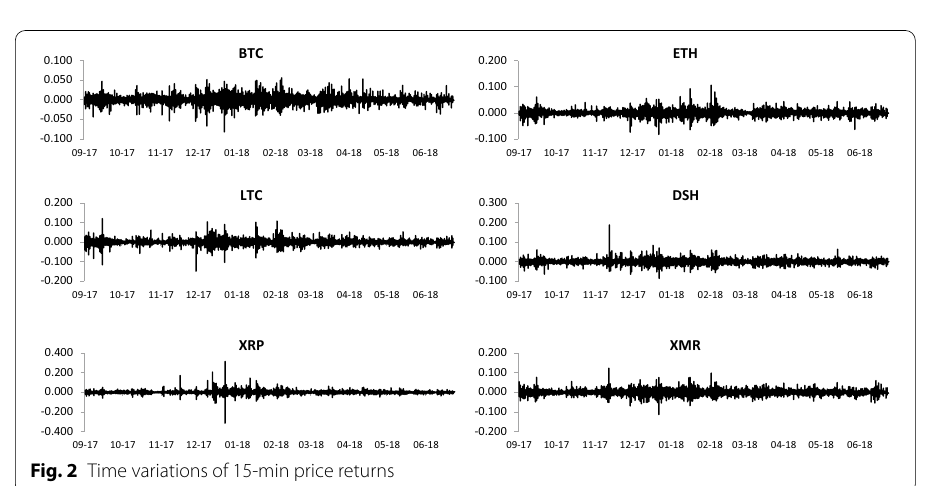
Fig. 2 Time variations of 15‑min price